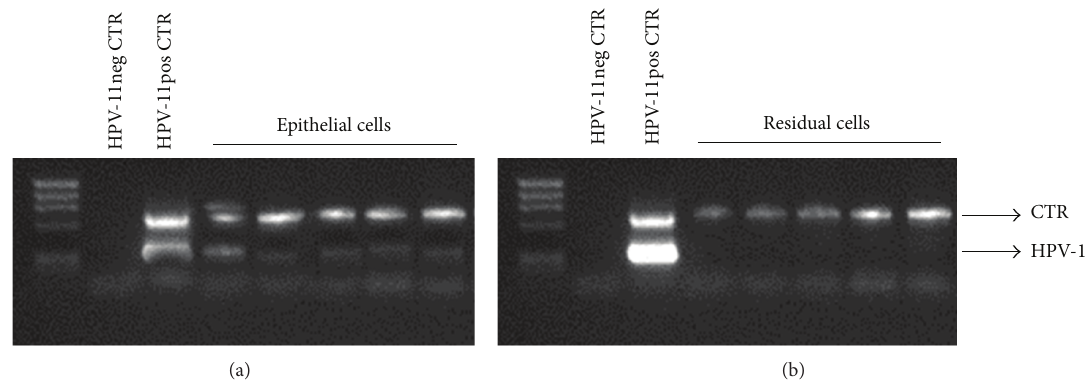
Figure 1: PCR products obtained from HPV-11 DNA analysis by HPV6/11 screen amplification kit (Sacace Biotechnologies) of (a) epithelial cells and (b) residual cells from polyps of the 5 relapsing SNP-WoAD patients. Internal control at 723 bp, HPV-11 at 425 bp. The kit has a sensitivity of 500